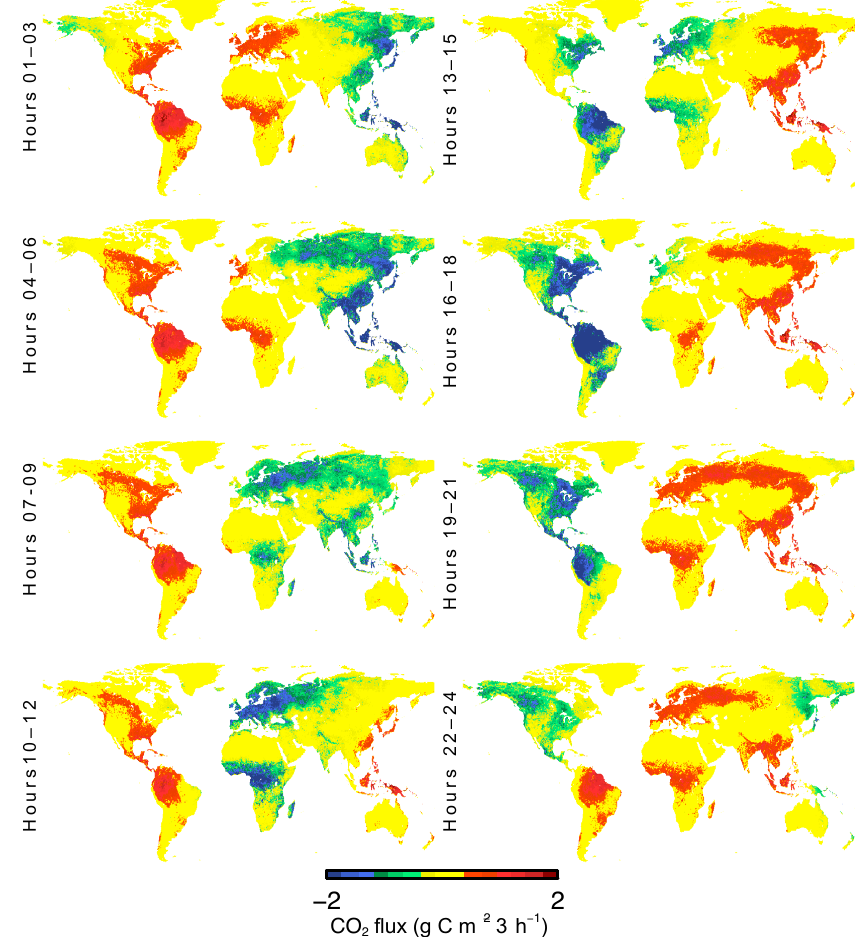
Figure 2. Vegetation productivity (e.g., blues/greens) follows the course of the sun for a single day of net ecosystem exchange (NEE or net CO 2 flux; g C m -2 3hr -1 ) for each 3-hourly period. Shown here, for example, is 1 July 2007 for the weighted ensemble mean product. All input data were given in a spatial resolution